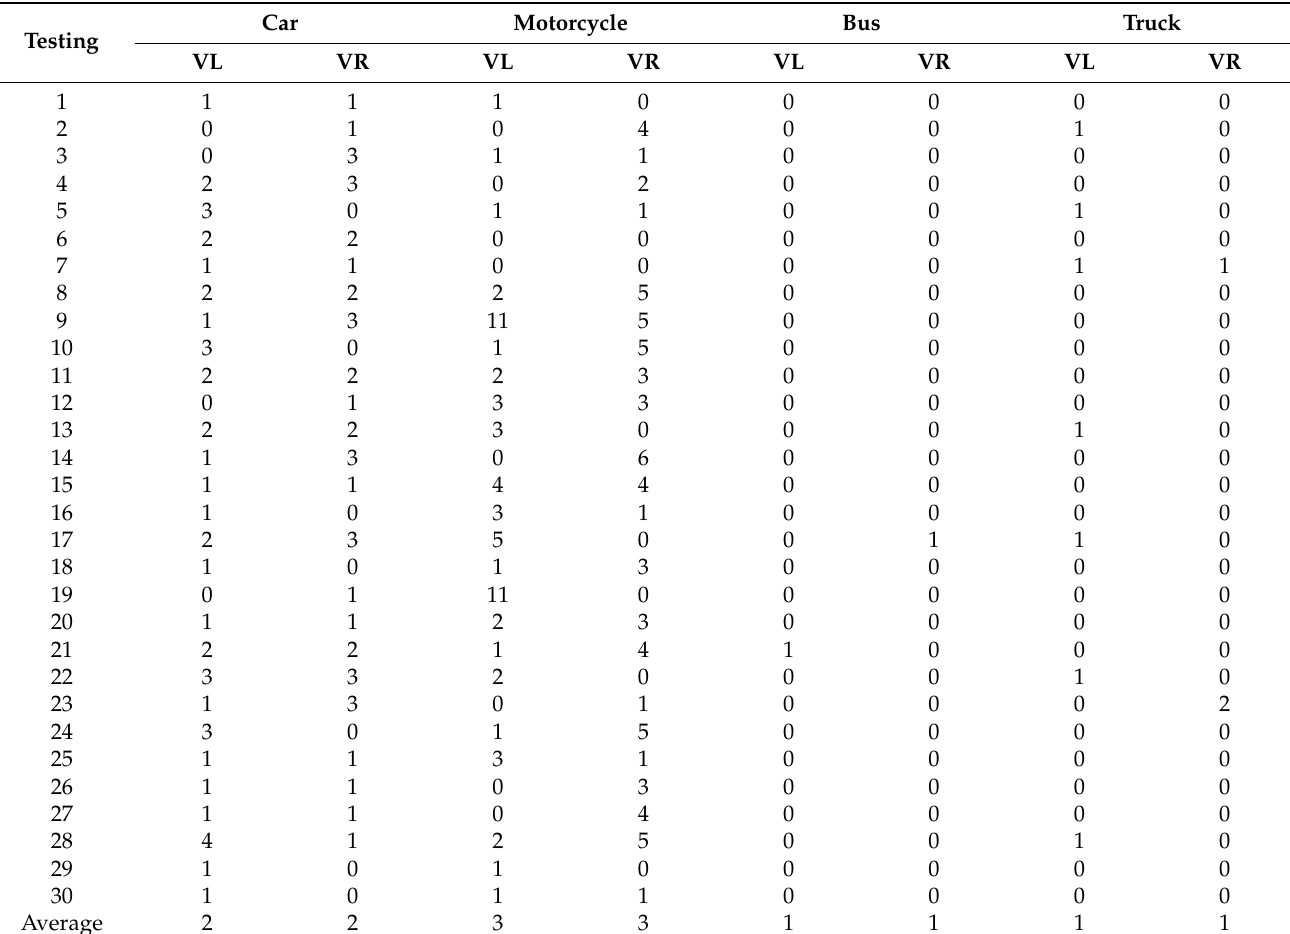
Table 11. Error rate in vehicle counting on Trunojoyo road segment.